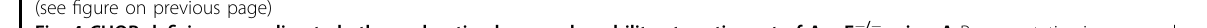
Fig. 4 CHOP de fi ciency ameliorated atherosclerotic plaque vulnerability at aortic root of ApoE − / − mice. A Representative images and quanti fi cation data of CHOP immunohistochemical staining at the aortic root. Black arrows indicate the area stained positively for CHOP. Scale bars, 200 μ m. n = 6. B – G Eight-week-old male ApoE − / − CHOP − / − mice and ApoE − / − littermates were fed a high-fat diet for 16 weeks. B Gross view of en face-prepared aortas stained with Oil Red O. The red dots are lesions stained positively for Oil Red O. Yellow arrows pointed to the Oil red O-stained lesions. C Representative image of Oil red O-stained aortic root lesion. Scale bars, 500 μ m. D Quanti fi cation of Oil red O positive area. E Representative image of H&E-stained aortic root lesion. Thin black arrows indicate the atherosclerotic lesions. Thick black arrows indicate the necrotic core. Scale bars, 500 μ m (top) and 200 μ m (bottom). F Quanti fi cation of aortic root lesion area (top) and necrotic area (bottom). G , H Collagen area at the aortic root was measured. Representative picrosirius red-stained sections ( G ) from each group are displayed next to the quanti fi cation data ( H ). Scale bars, 200 μ m. n = 5 – 11. Data are mean ± SD. * P < 0.05, ** P < 0.01; Student ’ s t